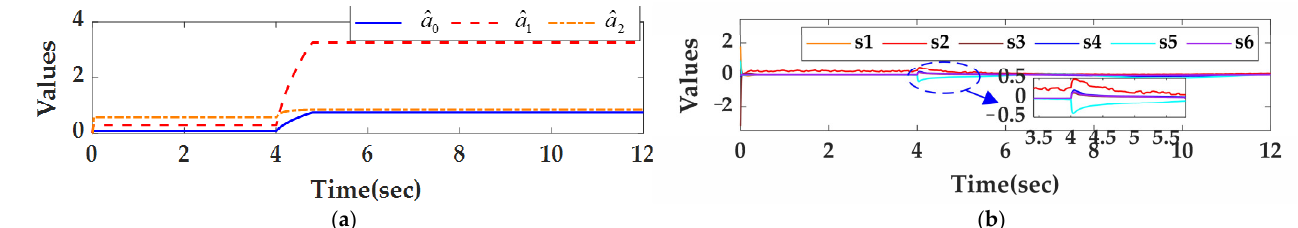
Figure 11. Trend of controller parameters: ( a ) adaptation of parameters; ( b ) sliding surfaces versus time with external disturbance.